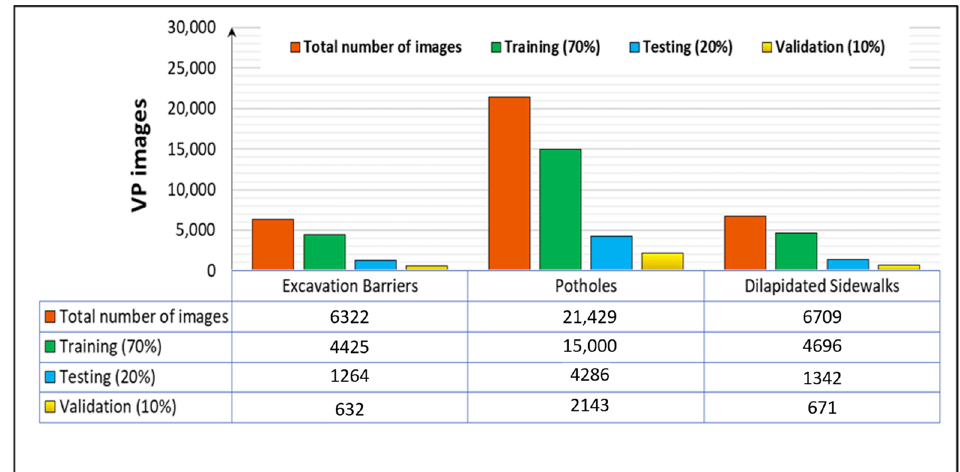
Figure 4. Visual pollution real dataset (i.e., the MOMRAH VP dataset) distribution over three different classes: excavation barriers, potholes, and dilapidated sidewalks. The dataset per class is split into 70% for training, 10% for validation, and 20% for testing.